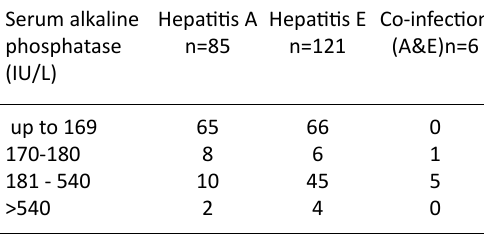
Table 4. Serum alkaline phosphatase in patients with hepatitis